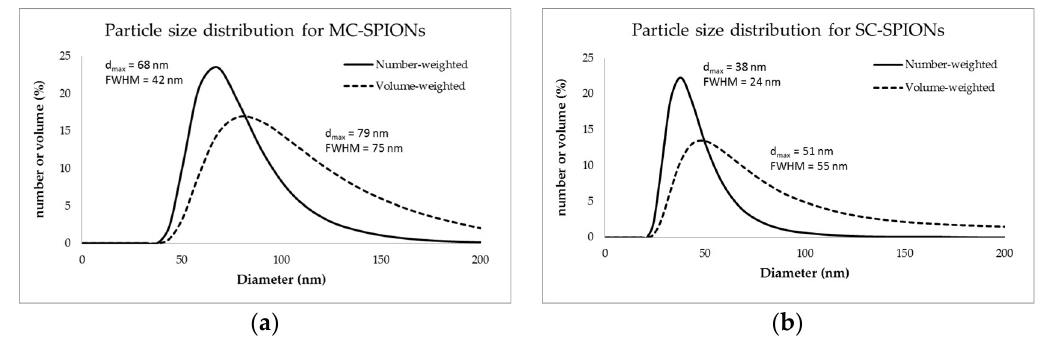
Figure 4. Transmission electron microscope (TEM) images of ( a ) MC-SPIONs and ( b ) SC-SPIONs, with a 100-nm scale bar.